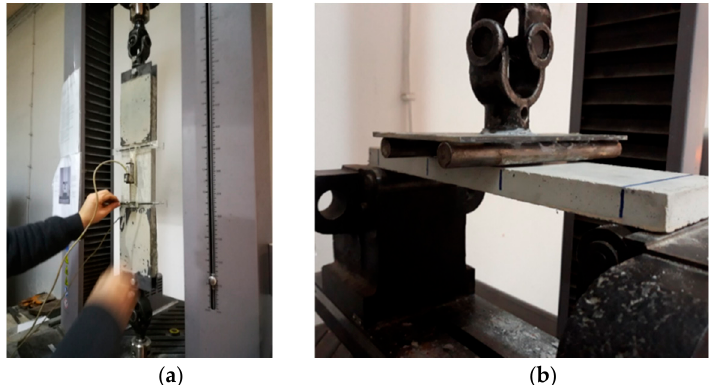
Figure 5. Tensile and flexure test setups: ( a ) tensile test; ( b ) flexure test.